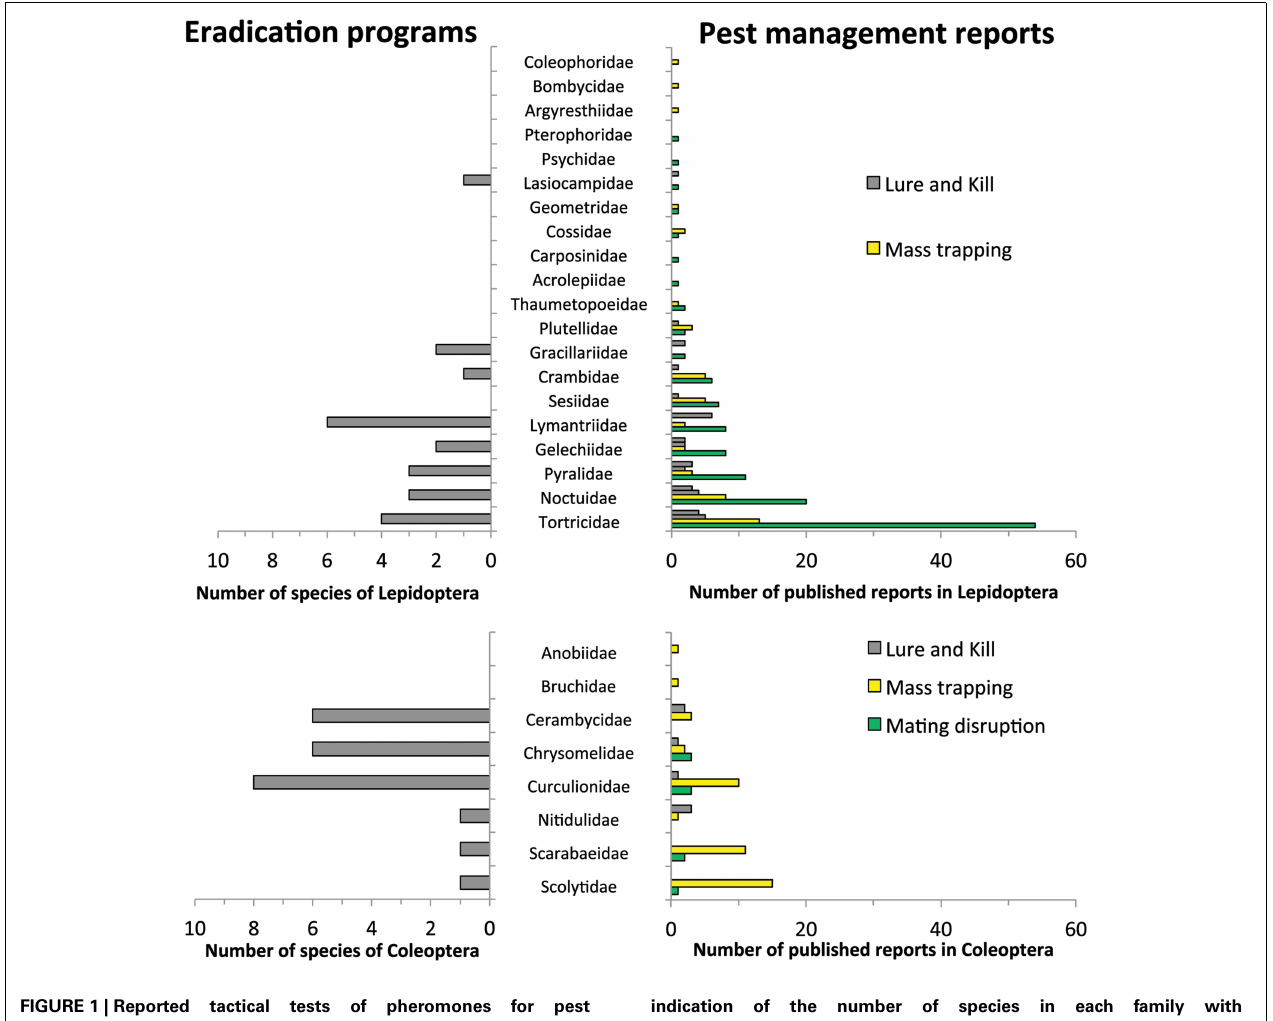
FIGURE 1 | Reported tactical tests of pheromones for pest management by family in Left: Lepidoptera, and Right: Coleoptera (data from www . pherobase . com), with an